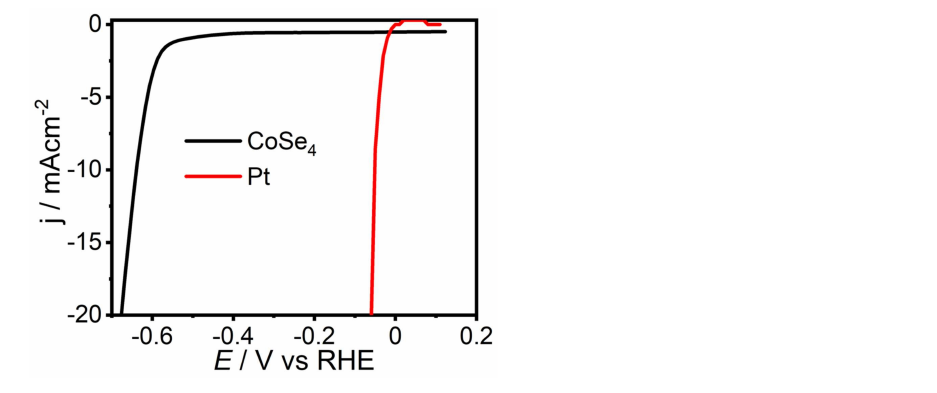
Figure 7. Polarization curves for HER with the CoSe 4 catalyst in N 2 -saturated 1.0 M KOH solution at a scan rate of 10 mV s − 1